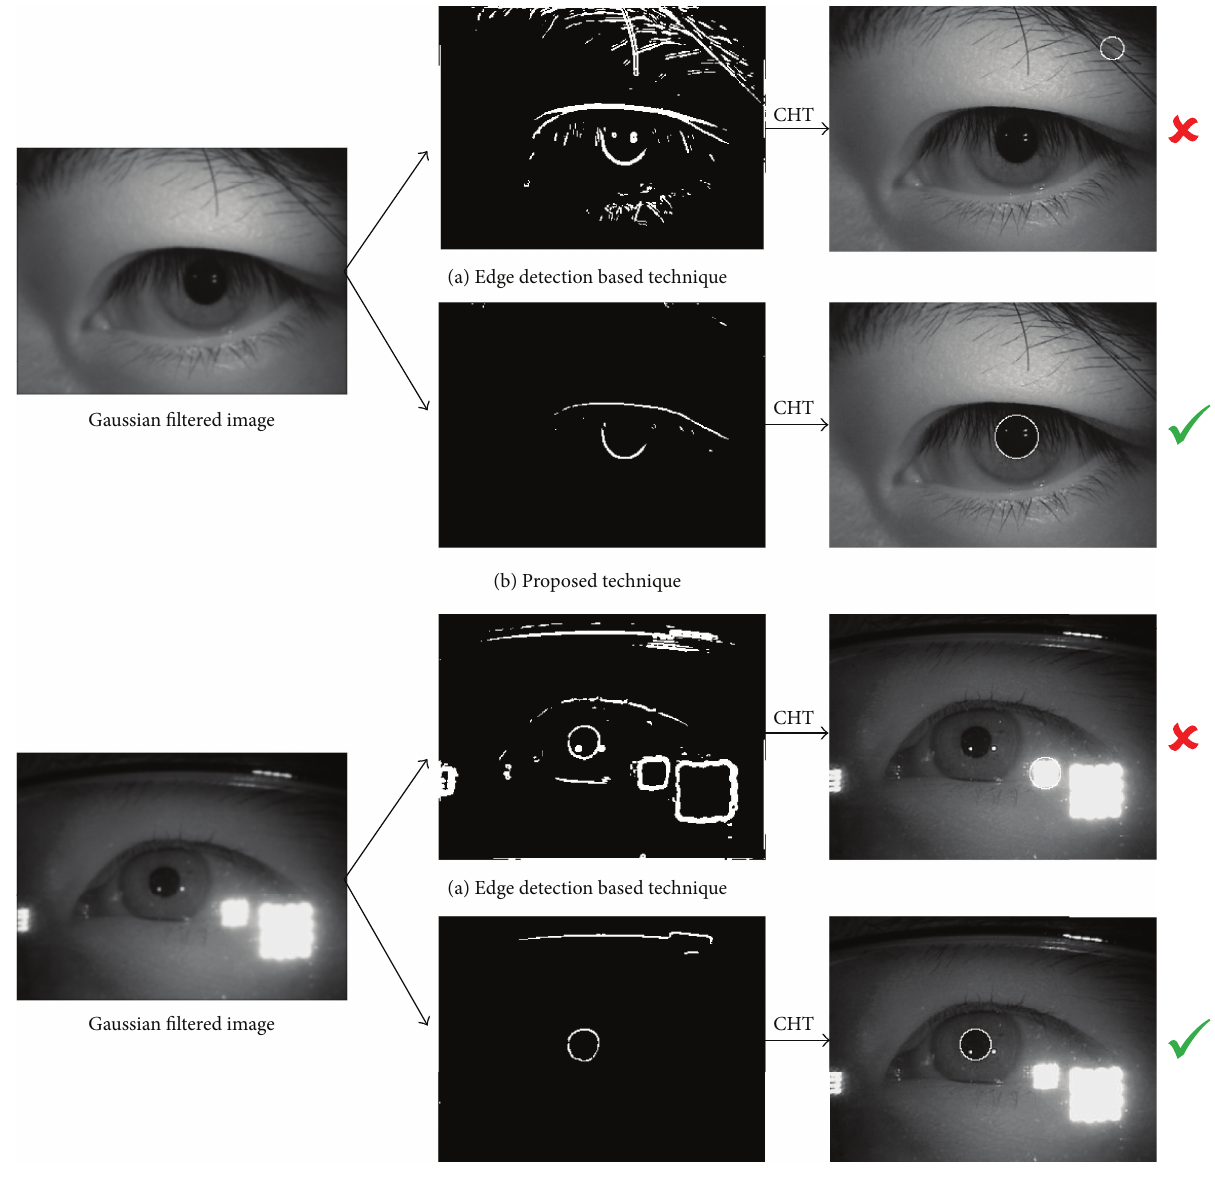
Figure 7: Examples of wrong pupil localization using edge detection based technique, which is corrected by the proposed technique.